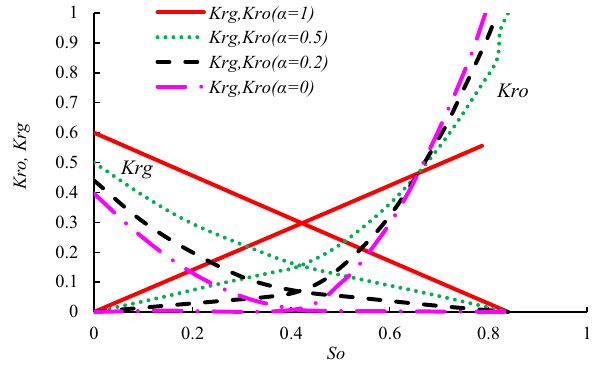
Fig. 2 Oil–gas relative permeability under different miscibility degrees ( α was the defined miscible